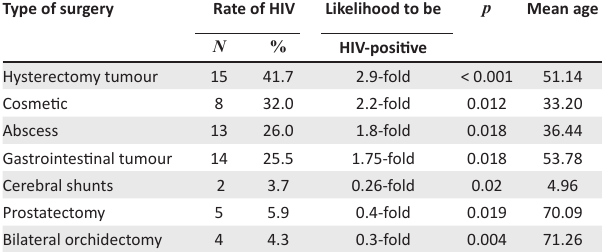
FIGURE 3: HIV status by type of surgery. TABLE 2: Association between HIV and certain types of